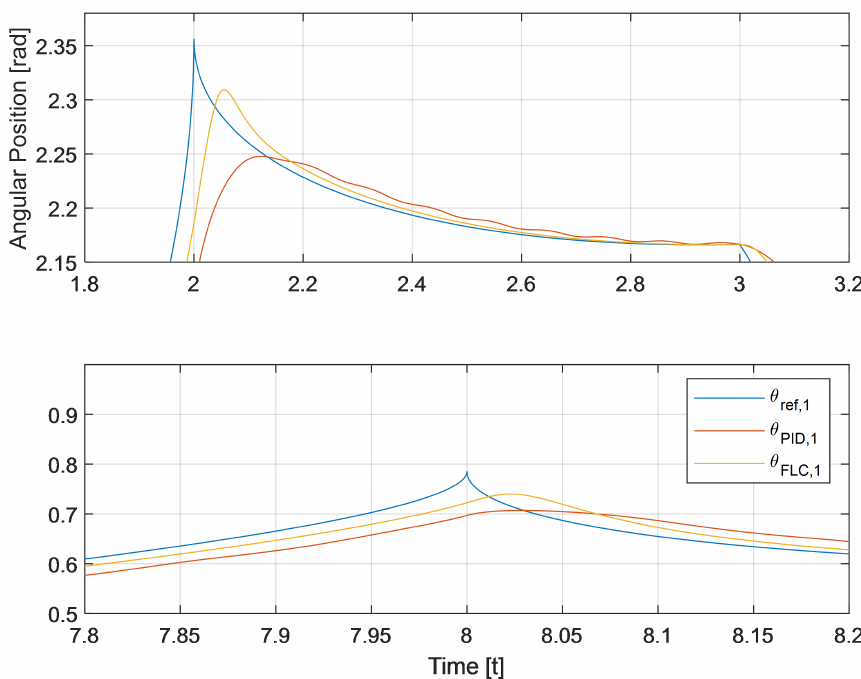
Figure 6. Zoom in the “cuspide” point managing.